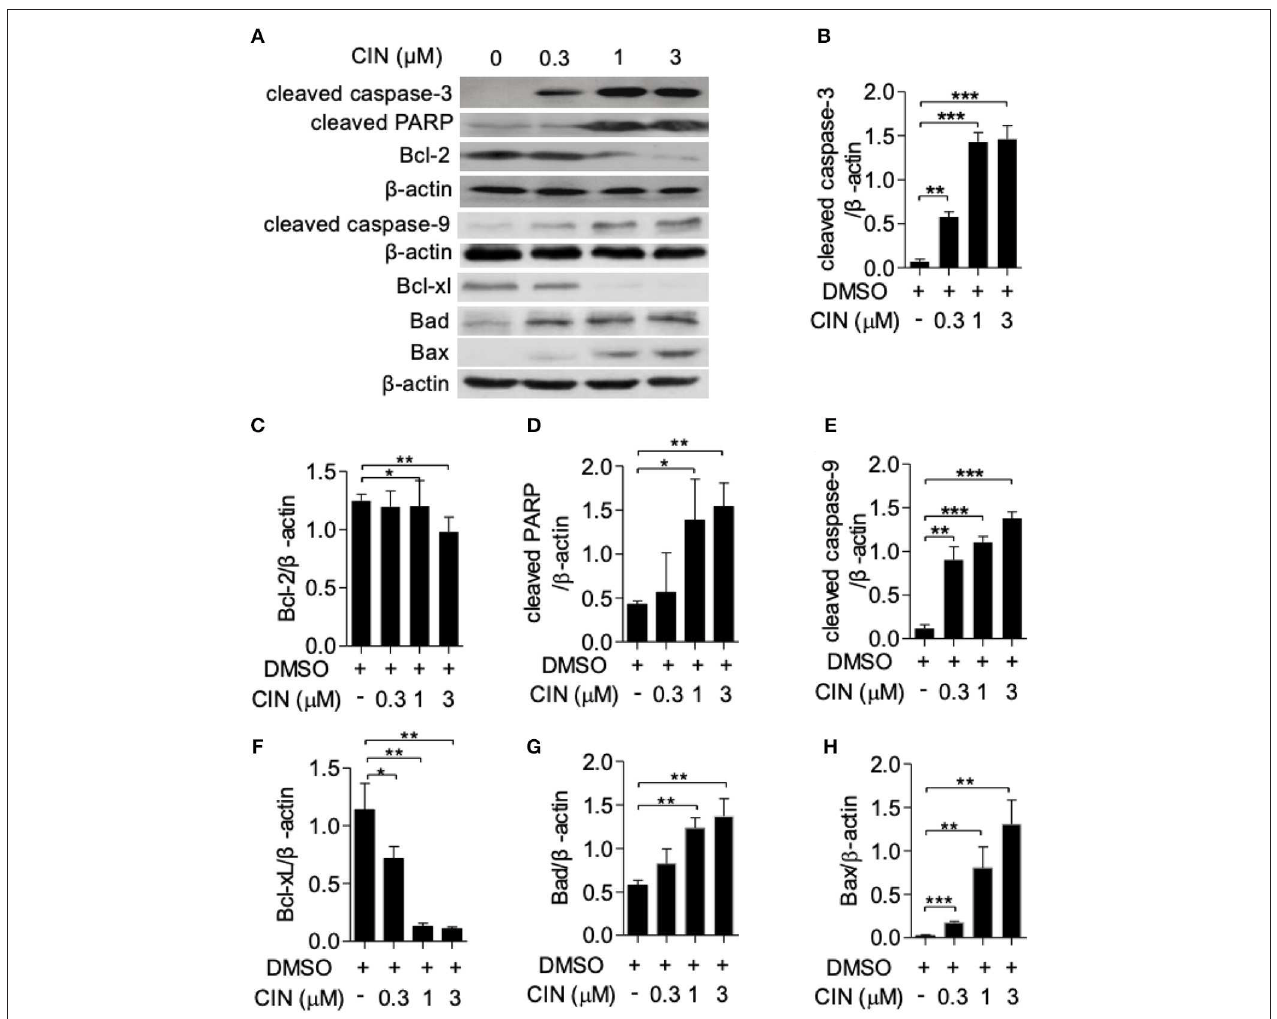
FIGURE 4 | Cinobufagin triggers apoptotic signaling pathways in OCM1 cells. OCM1 cells were treated with 0, 0.3, 1, and 10 µ M cinobufagin for 24h. (A) The expression of cleaved caspase-3, cleaved caspase-9, cleaved poly(ADP-ribose) polymerase (PARP), and Bcl-2 was detected by Western blot. β -Actin was used as a loading control. The expression of (B) cleaved caspase-3, (C) cleaved caspase-9, (D) cleaved PARP, (E) Bcl-2, (F) Bcl-xL, (G) Bad, and (H) Bax was quantified using ImageJ software. The results are shown as the mean ± SEM of three independent experiments [* P < 0.05, ** P < 0.01, and *** P < 0.001 compared with the DMSO